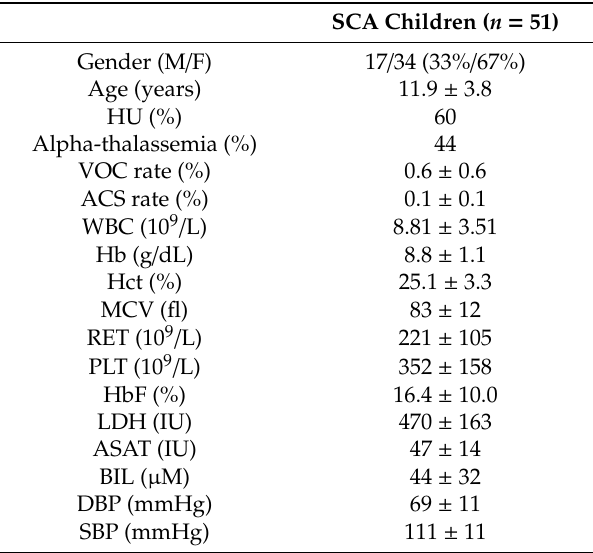
Table 1. General characteristics of the whole cohort.